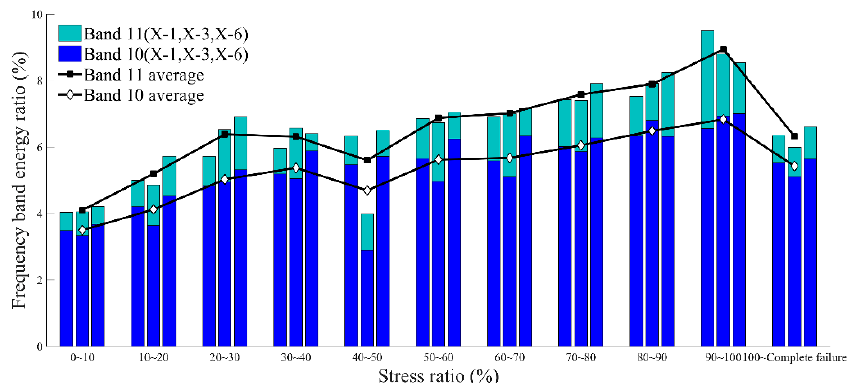
Figure 11. The relationship between the stress ratio and the average energy ratio in the high-frequency band (bands 10 and 11).